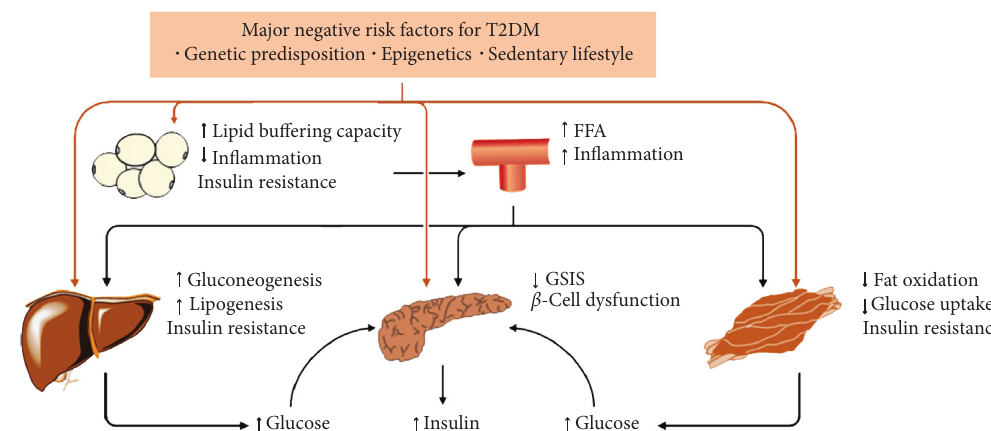
Figure 1: T2DM pathophysiology. A matrix of negative genetic, epigenetic, and lifestyle factors interact with one another and induce dysfunction of pancreatic β -cells and insulin resistance in the liver, skeletal muscle, or adipose tissue, thereby leading to the development of hyperinsulinemia and hyperglycemia. Moreover, once reduced lipid-buffering capacity in adipose tissue occurs, circulating lipid con- centrations increase, leading to ectopic fat storage in the liver, skeletal muscle, and pancreas as well as the development of insulin resistance and dysfunction of pancreatic β -cells. In addition, inflamed adipose tissue results in a low-grade systemic inflammation, which contributes to the development of insulin resistance and T2DM. FFA, free fatty acid; GSIS, glucose-stimulated insulin secretion; T2DM, type 2 diabetes mellitus.